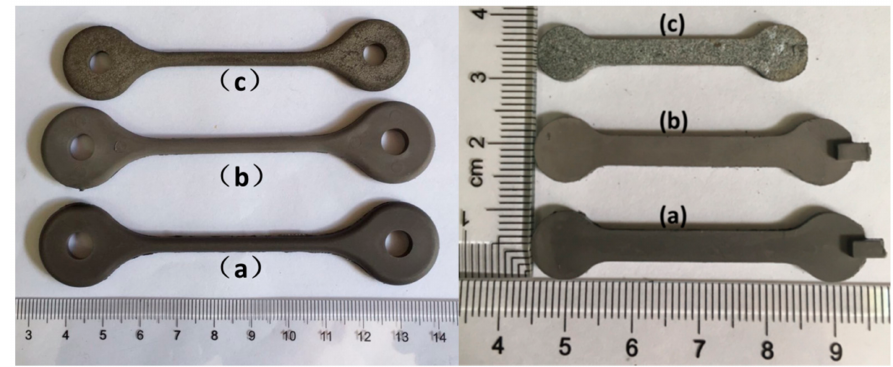
Figure 10. Shrinkage variation of sample A and C ( a ) green part; ( b ) solvent-debinded part; and ( c ) sintered part.